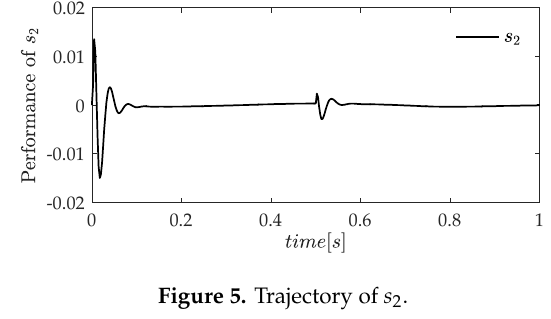
Figure 5. Trajectory of s 2 .